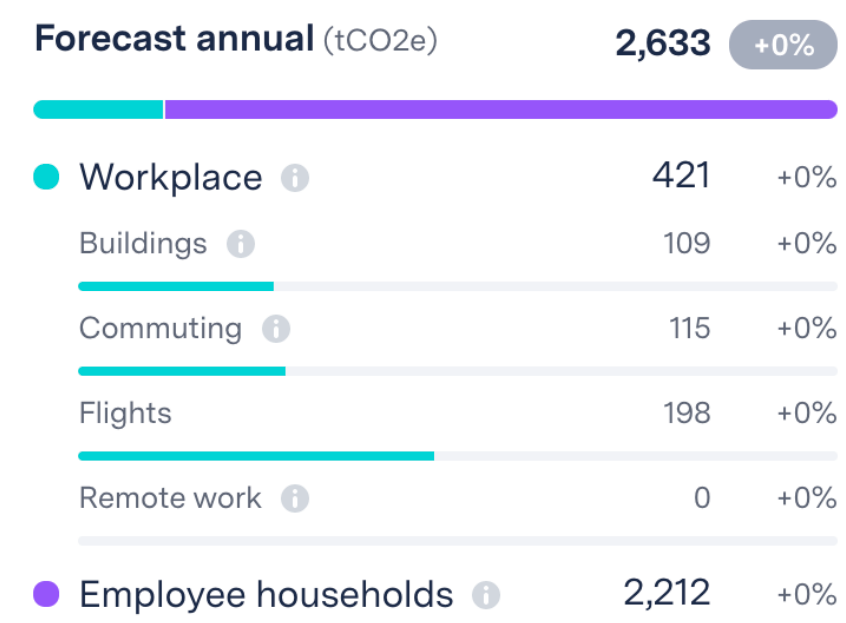
Figure 2. Forecast—5 days at the office, accessed on 9 September 2021